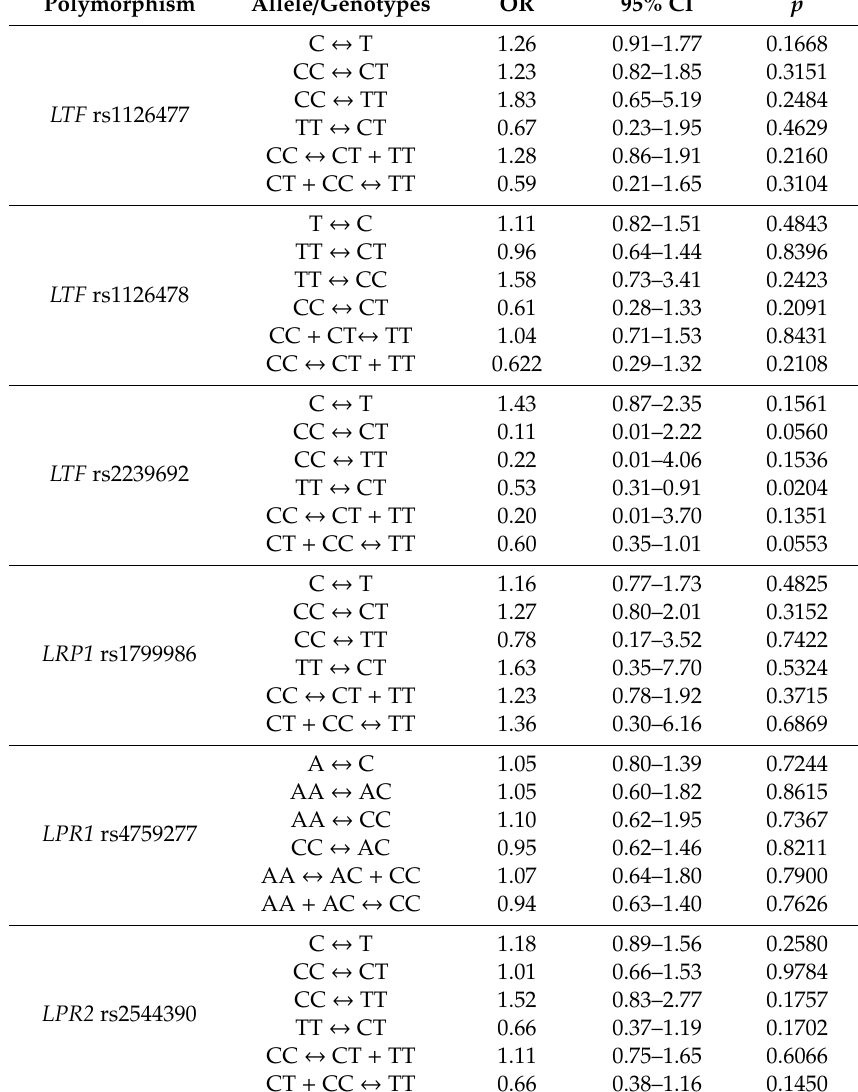
Table 4. Odds ratios (OR) and 95% confidence interval (CI) for the associations between analysed gene polymorphisms and the prevalence of metabolic disorders in obese